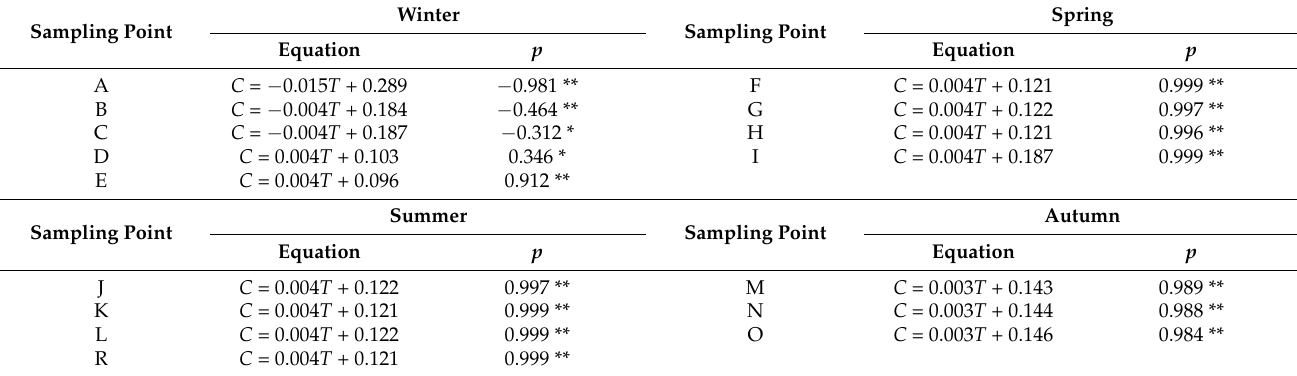
Table 2. The relationship between electrical (EC) conductivity and water temperature